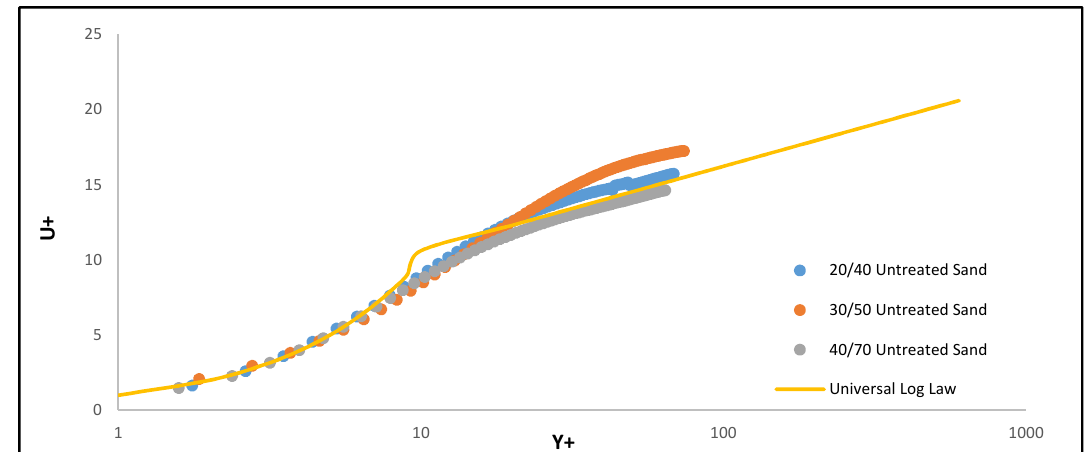
Figure 7. Near-wall (dimensionless) velocity profiles for the flow of the polymer fluid over the sand bed at a superficial velocity of 0.25 m/s.